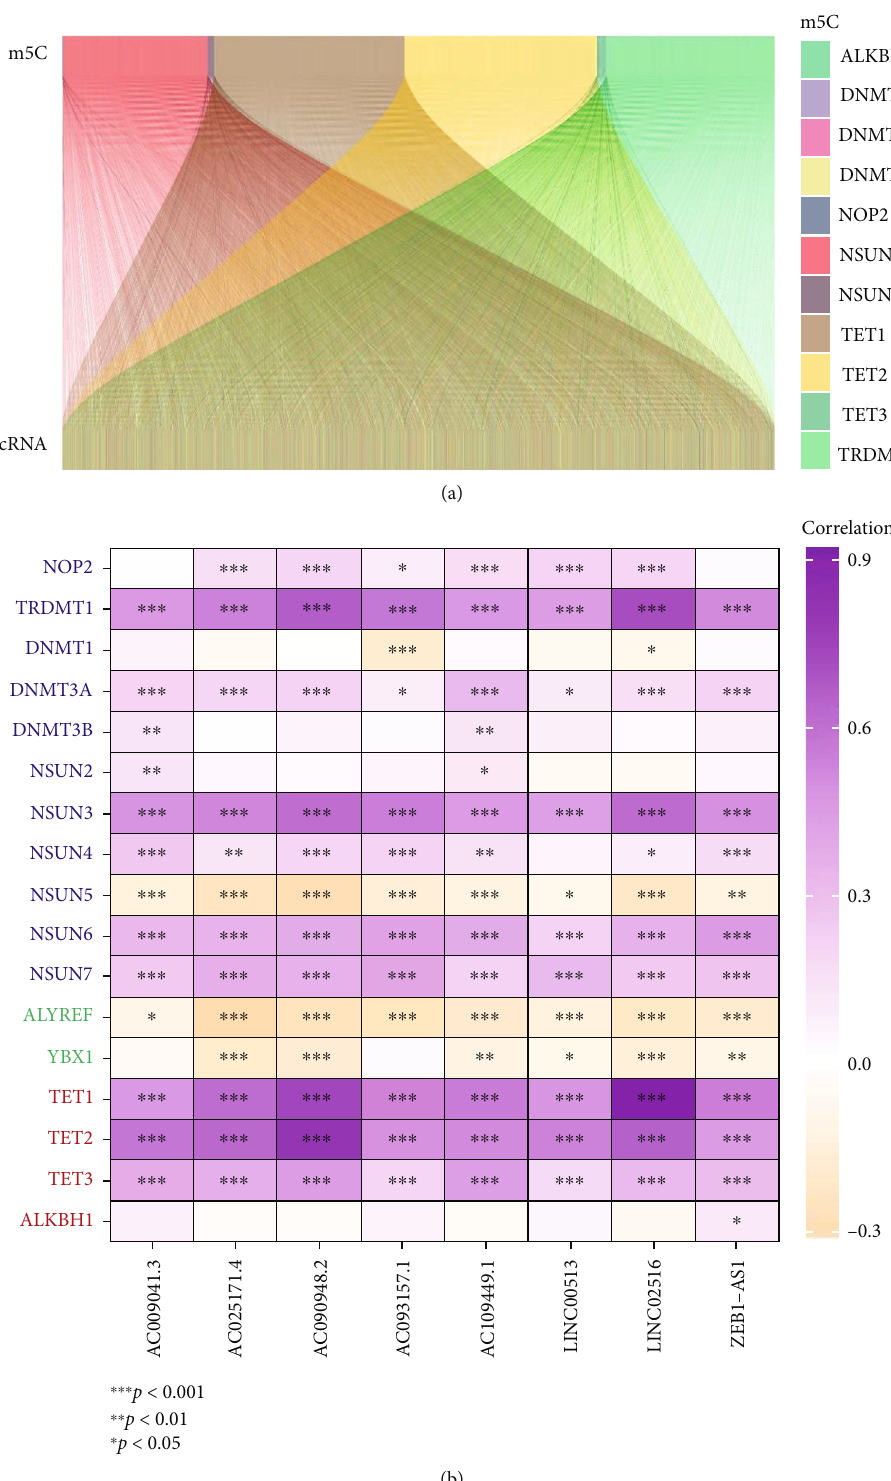
Figure 1: Identi fi cation of m 5 CRlncRNAs. (a) A Sankey plot for the network of m 5 C genes and associated m 5 CRlncRNAs. (b) Heatmap for correlation between 17 m 5 C genes and 8 m 5